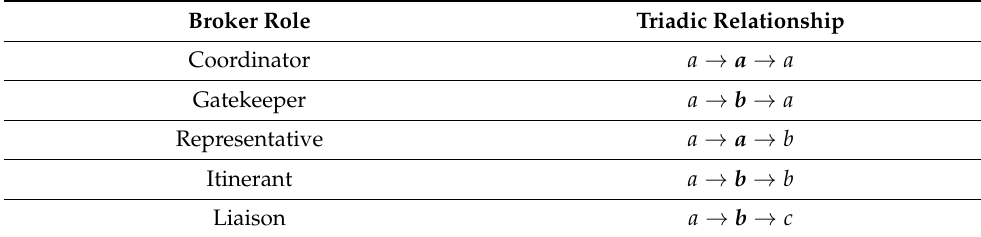
Table 4. Triadic relationships of broker